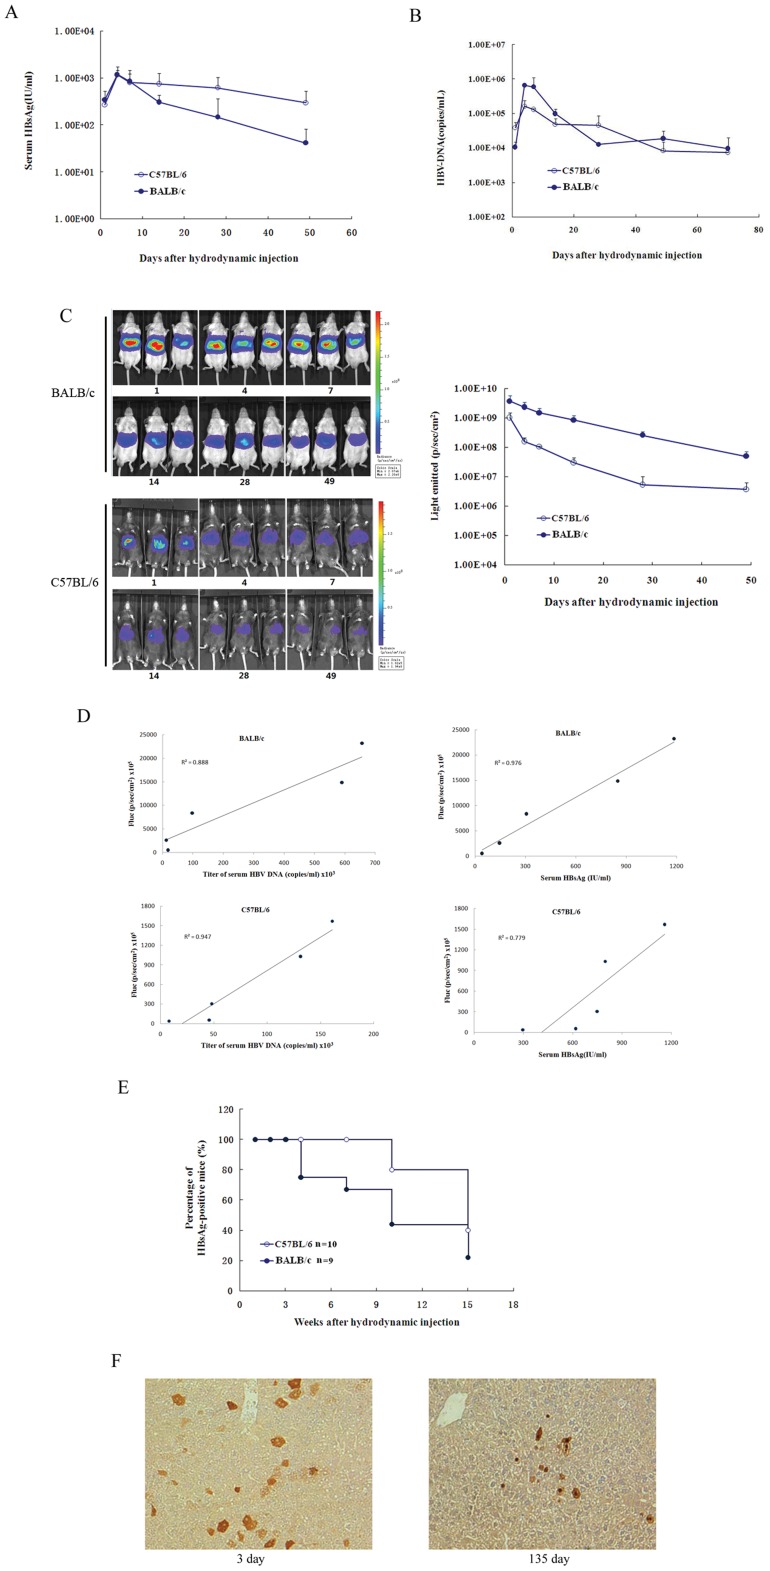
HBV persistence in mice induced by hydrodynamic injection of pGL3/Fluc-HBV1.2.A. Titer of serum HBsAg in C57BL/6 or BALB/c mice after HBV plasmid injection. The detection limitation is 0.05 IU/ml. B. Serum HBV DNA levels in C57BL/6 or BALB/c mice after HBV plasmid injection. The detection limitation is 100 copies/ml. C. Bioluminescence image of C57BL/6 (H-2b) or BALB/c (H-2d) mice after hydrodynamic injection. D. Fluc expression in the liver and both serum HBsAg and HBV DNA levels showed strong linear correlation. E. Immunohistochemical staining for HBcAg in hepatocytes of HBsAg-positive C57BL/6 mice (magnification, 200x). In C57BL/6 mice, HBcAg-positive cells were maintained at stable levels on day 3 and day 135. F. Positive rate of serum HBsAg in C57BL/6 (n = 10) or BALB/c (n = 9) mice receiving injection with pGL3/Fluc-HBV1.2 at different time points after injection.